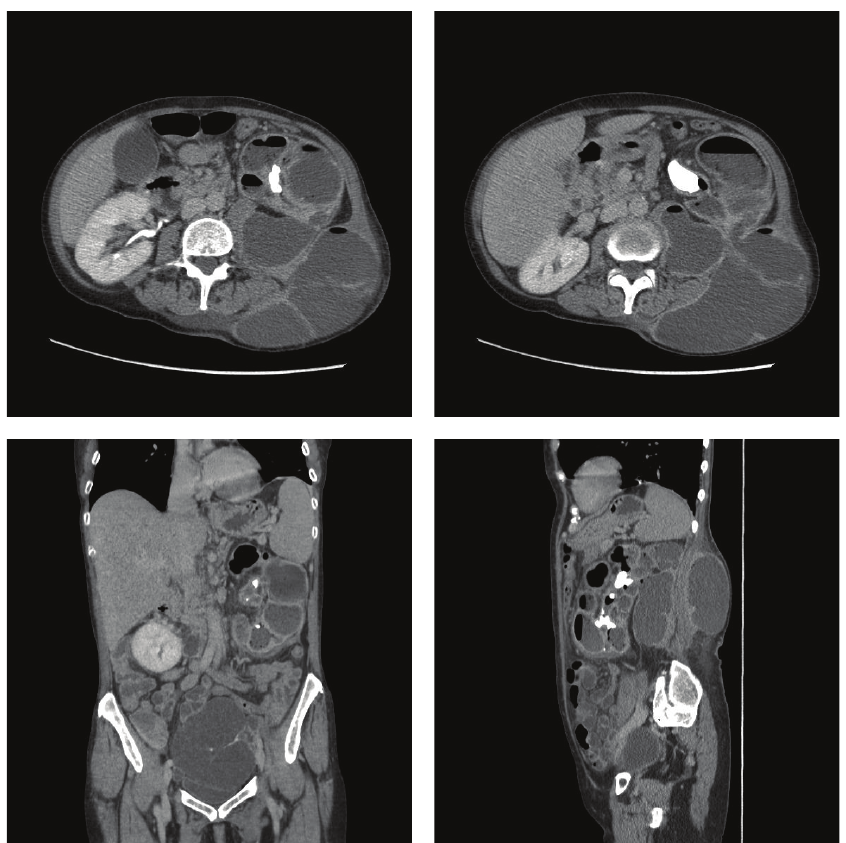
Figure 2: CT abdomen/pelvis with IV contrast and delayed phase demonstrating a left kidney with parenchyma replaced with multiple large hypodense collections containing fluid and gas, a left staghorn calculus, and a communication between the kidney and large flank collection. Additionally, a 13.5 × 7.7 cm multiloculated pelvic mass was